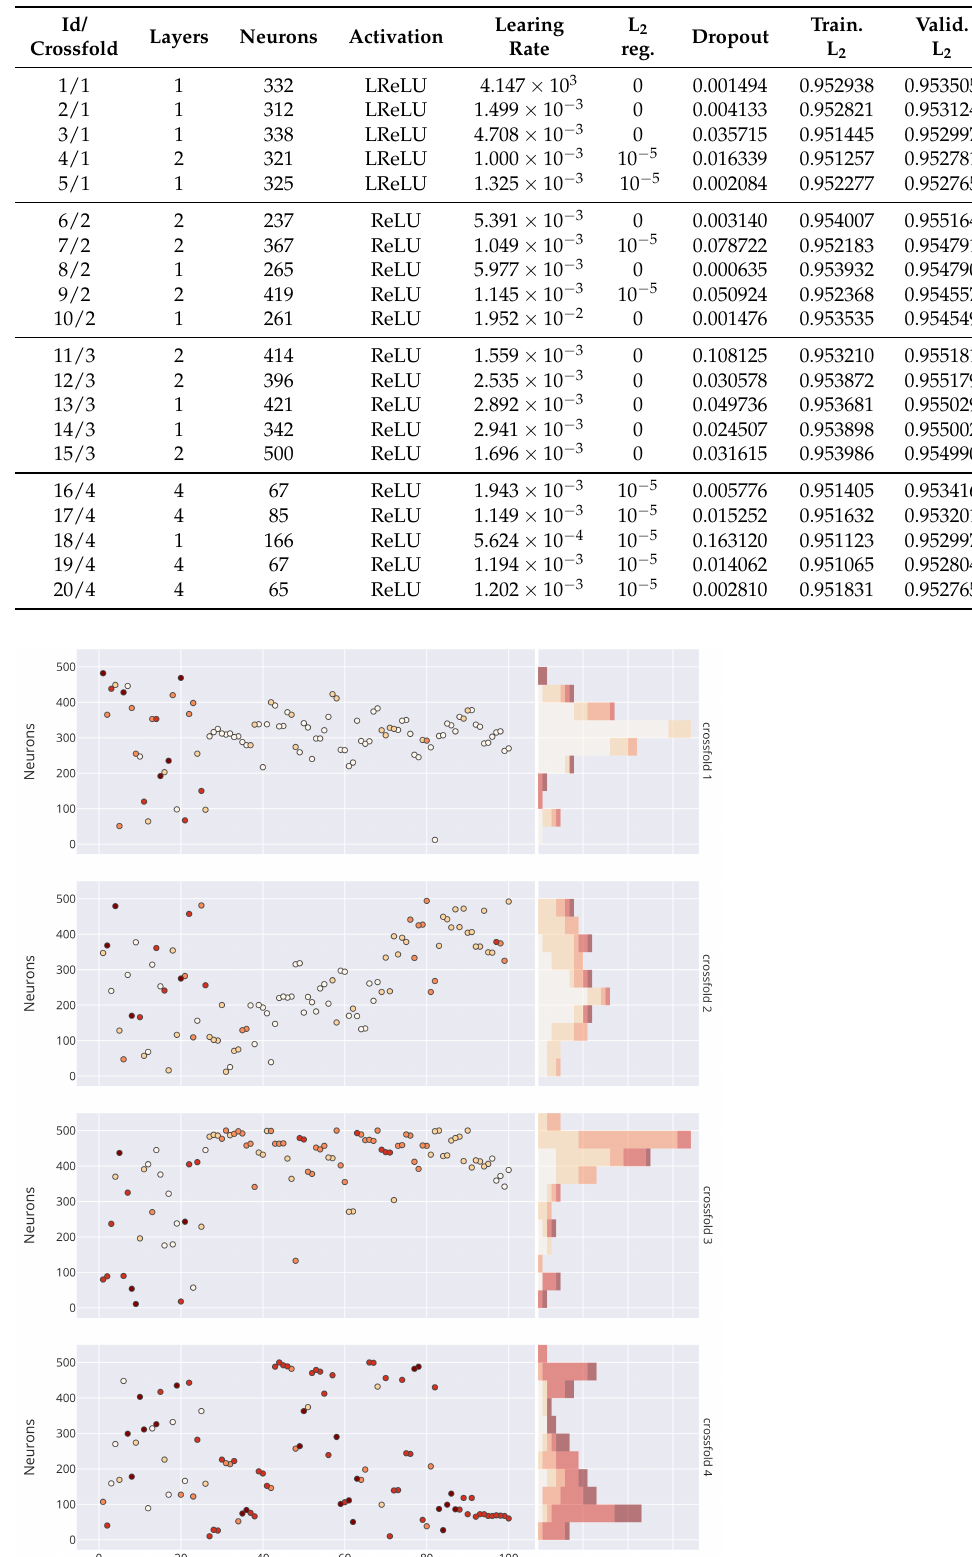
Table 3. The best five configurations for each crossfold (all models used logarithmic normalization).